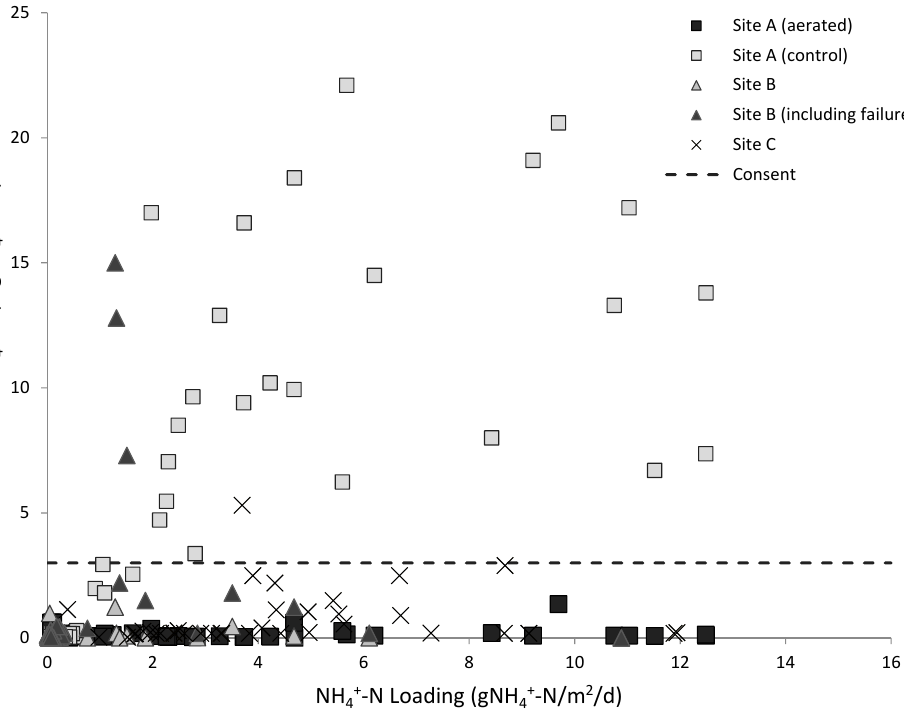
Figure 2. Ammonium loading rates and corresponding effluent ammonium concentrations at all sites.